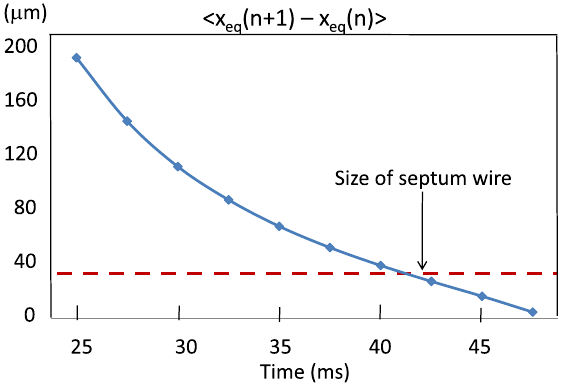
FIG. 21. Averaged turn separation vs. extraction